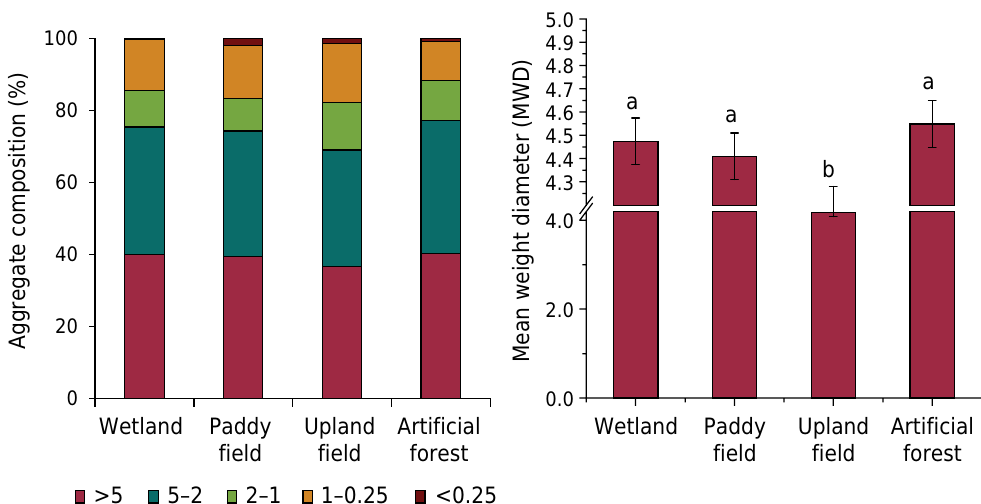
Figure 2. Soil aggregate composition and mean weight diameter (MWD) of different land-uses in the Sanjiang Plain wetlands. Different small letters above the bars represent significant differences